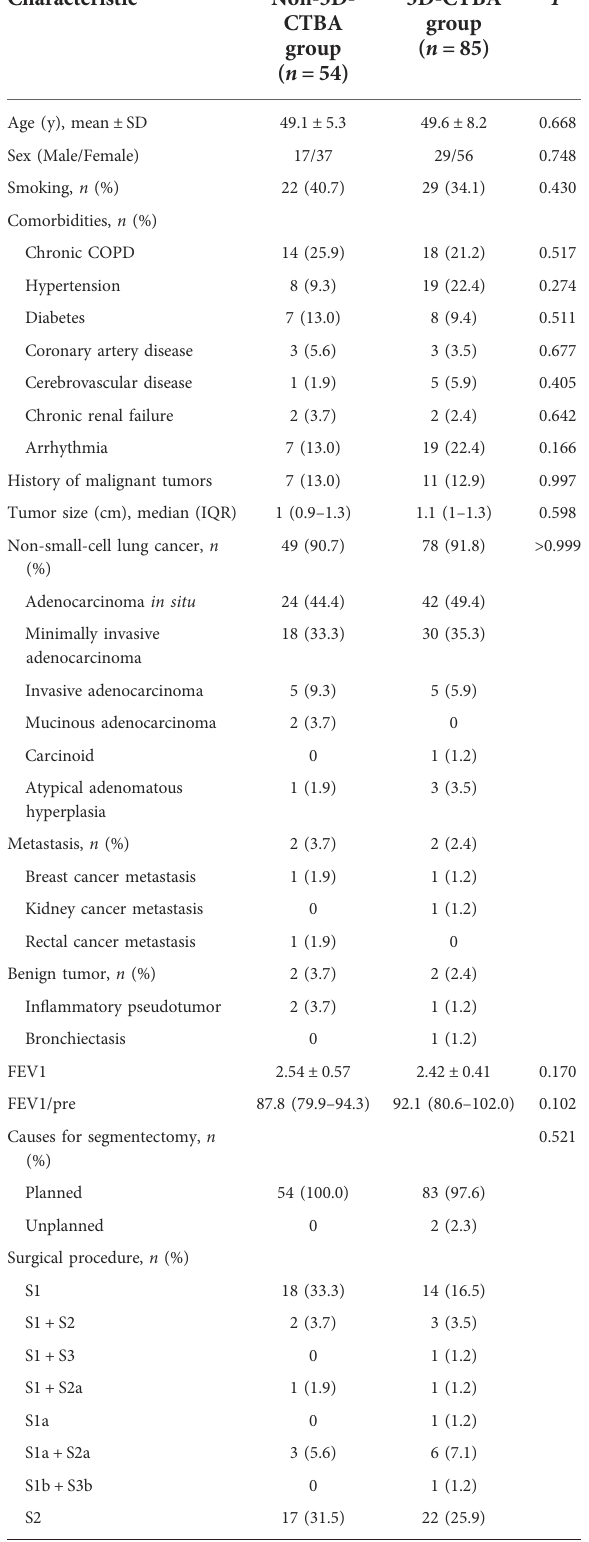
TABLE 1 Comparison of baseline data between the two groups of patients who underwent segmentation of the right upper lobe.